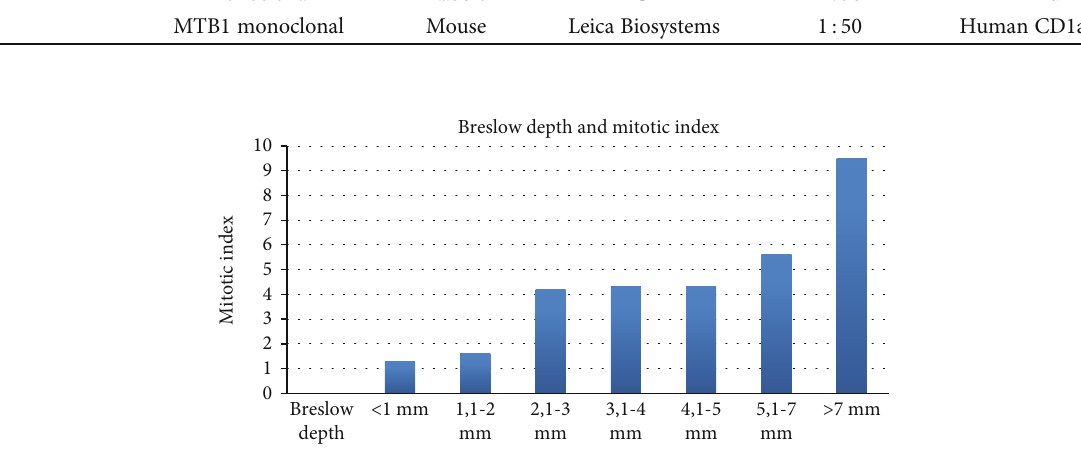
Figure 1: Distribution of the Breslow depth and mitotic index in our